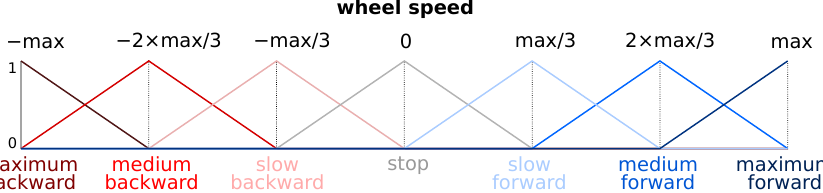
Figure 10. Output membership functions. Note that the left wheel speed and the right wheel speed have the same membership function, and that “max” means the maximal possible speed value.